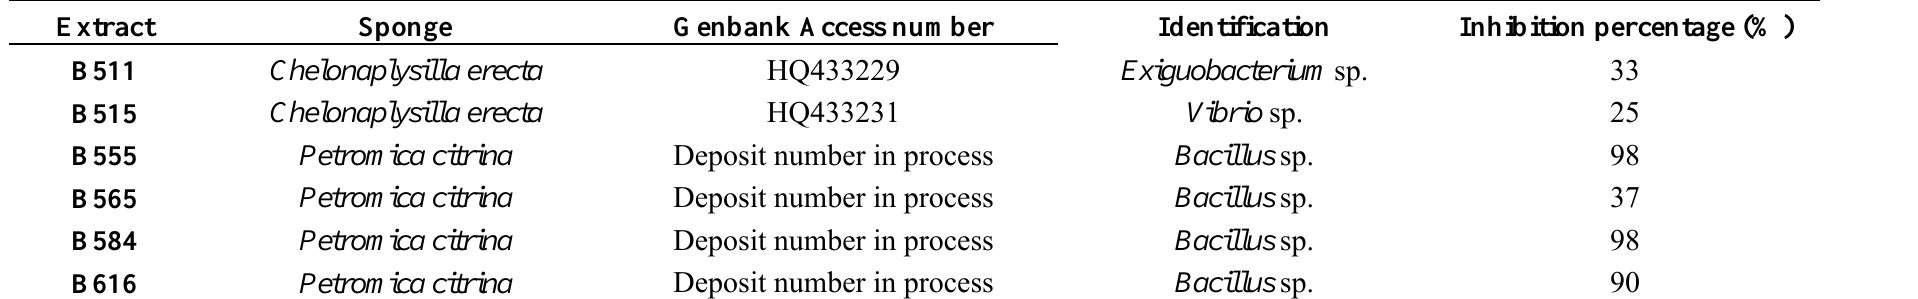
Table 1 .General characteristics of the extracts evaluated for antiviral